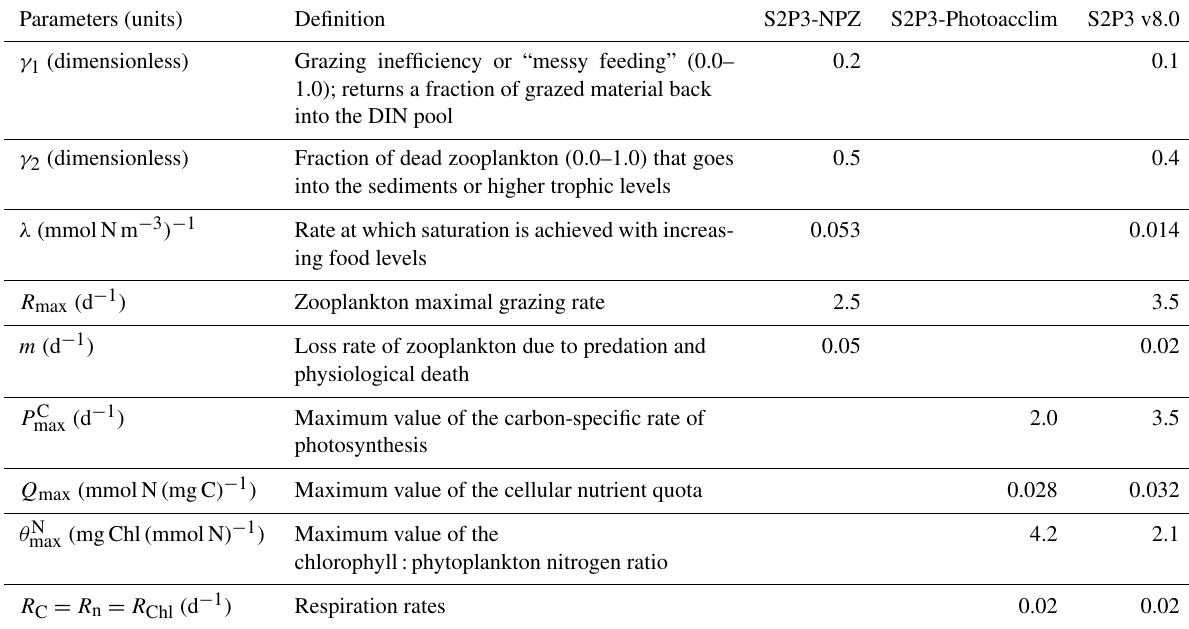
Table 1. List of parameter values, including units and definitions for the calibrated S2P3-NPZ, S2P3-Photoacclim, and S2P3 v8.0 models. Parameters